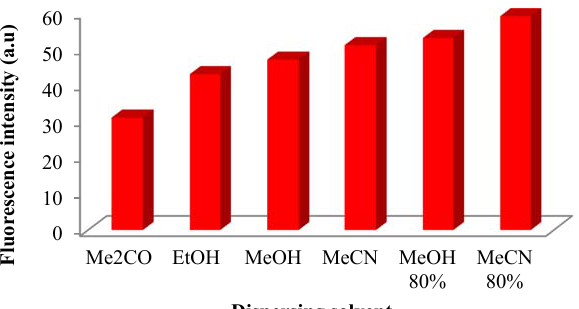
Fig. 6. Effect of dispersing solvent on the recovery of ZEN. Conditions: extraction solvent, 320 µL of 1-octanol; water volume, 15 mL, equilibration time, 60 s, adsorbent amount, 40 mg; adsorption time, 3 min; desorption time, 4 min, desorption solvent volume and type, 1 mL of MeCN.